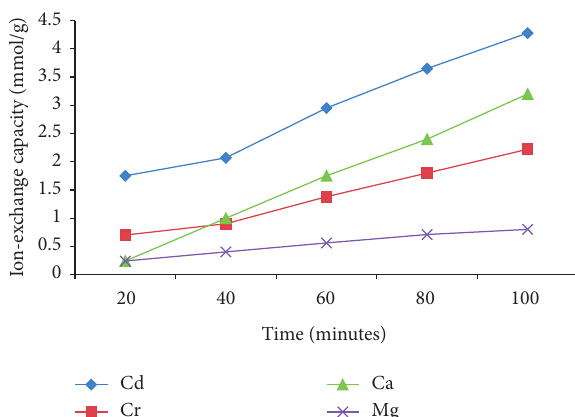
Figure 5: Effect on contact time for IEC on the “Dowex” 50-X8